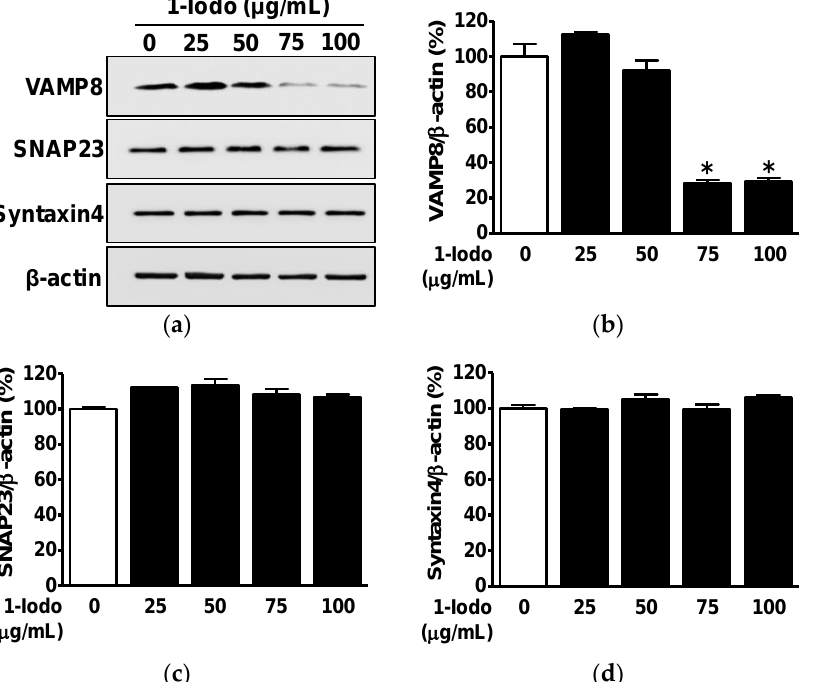
Figure 1. Effects of 1-iodohexadecane on the expressions of SNARE proteins in RBL-2H3 cells. ( a ) RBL-2H3 mast cells were incubated for 48 h in the presence or absence of 1-iodohexadecane (1-Iodo; 25–100 µ g/mL). Cell lysates were immunoblotted with the indicated antibodies. ( b – d ) Graphs show the expression levels of the VAMP8 ( b ), SNAP23 ( c ), and syntaxin 4 ( d ) proteins shown in panel a. Results are expressed as mean percentages ± SEMs versus untreated cells ( n = 3). * p < 0.05 vs. untreated cells.